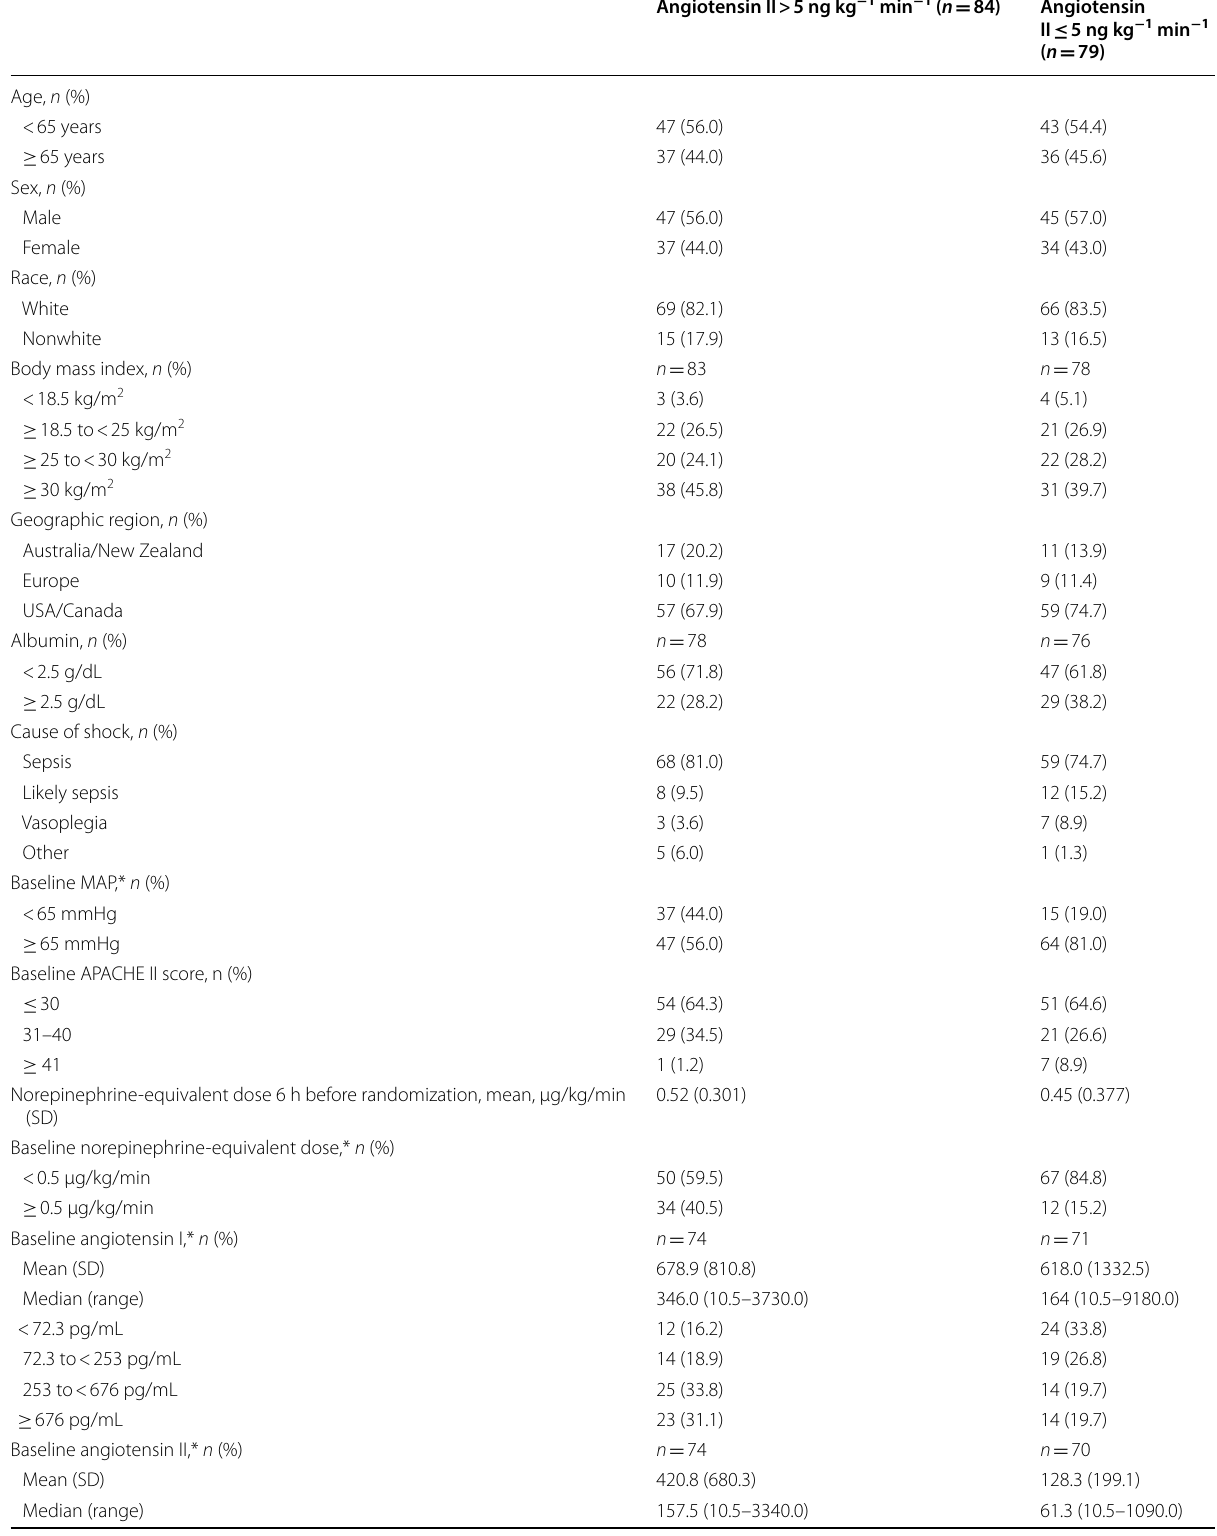
Table 1 Baseline disease and demographic characteristics in analysis